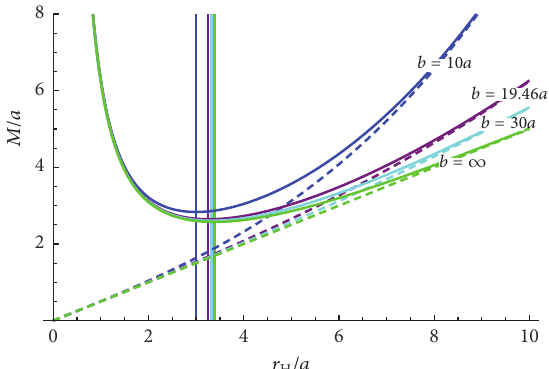
Figure 2: Plot of the relation of 𝑀 with respect to 𝑟 H . The solid curves correspond to the relation equation (6), the dashed curves correspond to the relation of the ordinary Schwarzschild-AdS black hole with 𝑀 = (𝑟 H /2)(1 + 𝑟 2 H /𝑏 2 ) , and each vertical line lies at the extremal radius of the curve with the same color. The blue, purple, cyan, and green colors correspond to the cases of 𝑏/𝑎 = 10 , 19.46 (the critical vacuum pressure), 30 , and ∞ , respectively.